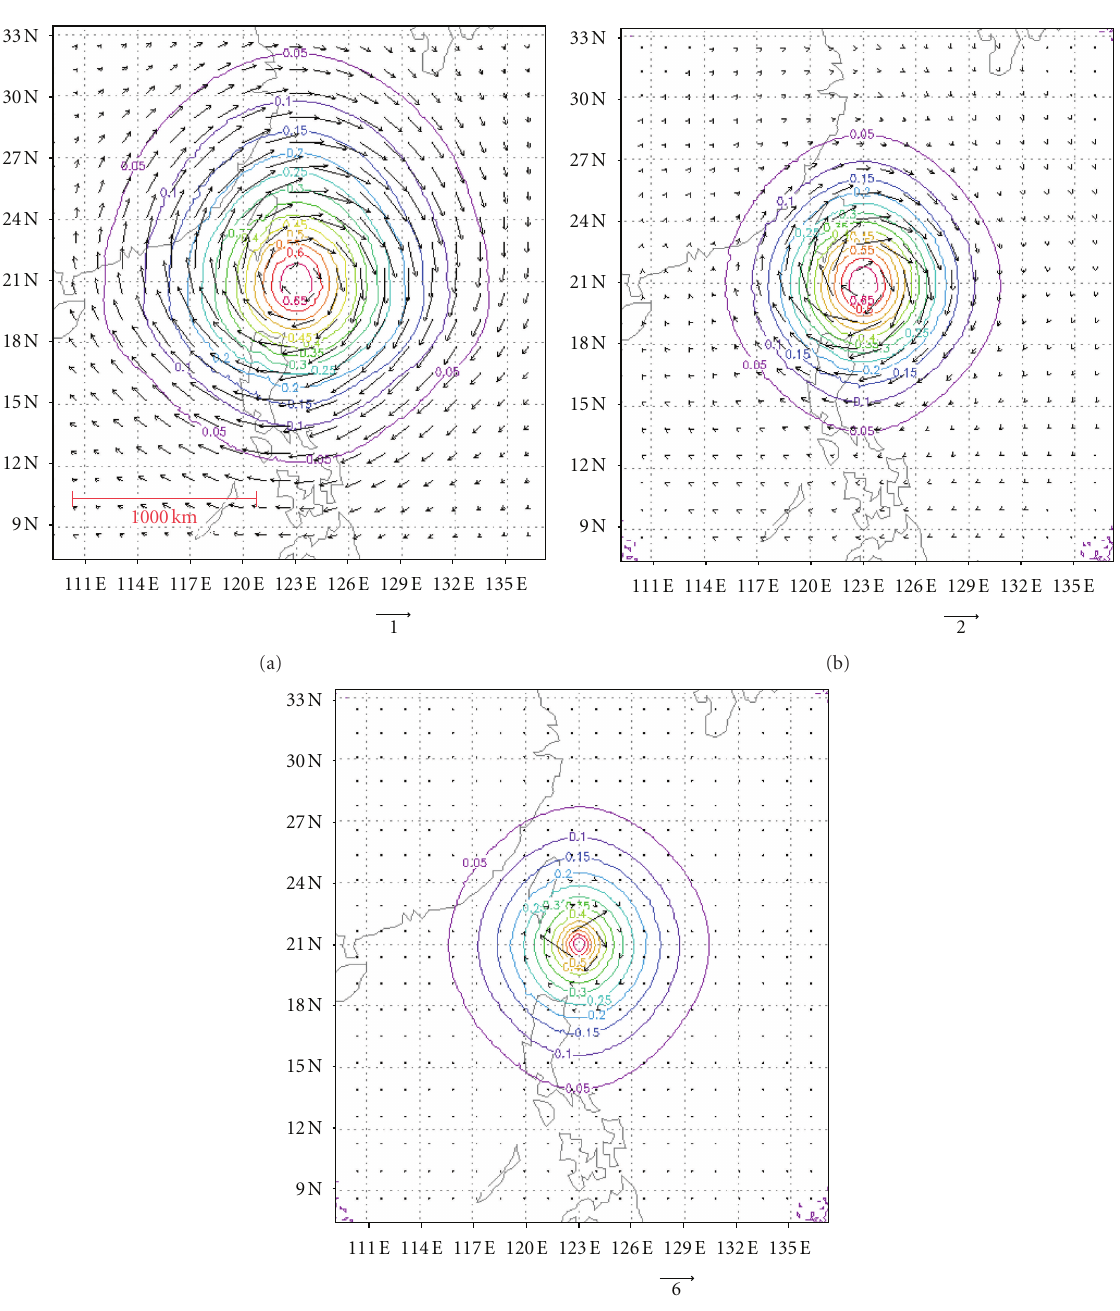
(c) Figure 2: The incremental adjustment in temperature (contours) and velocity (vectors) at 500 hPa as a result of a “single observation” experiment for WRF 3DVAR with a 1 ◦ K temperature perturbation given at a grid point. The three panels are with (a) LEN SCALING = 1.0, (b) LEN SCALING = 0.5, and (c) LEN SCALING = 0.1. All three cases are with VAR SCALING = 1.0. The scale of velocity vector is indicated below each panel. The red bar in panel (a) marks the distance of 1000